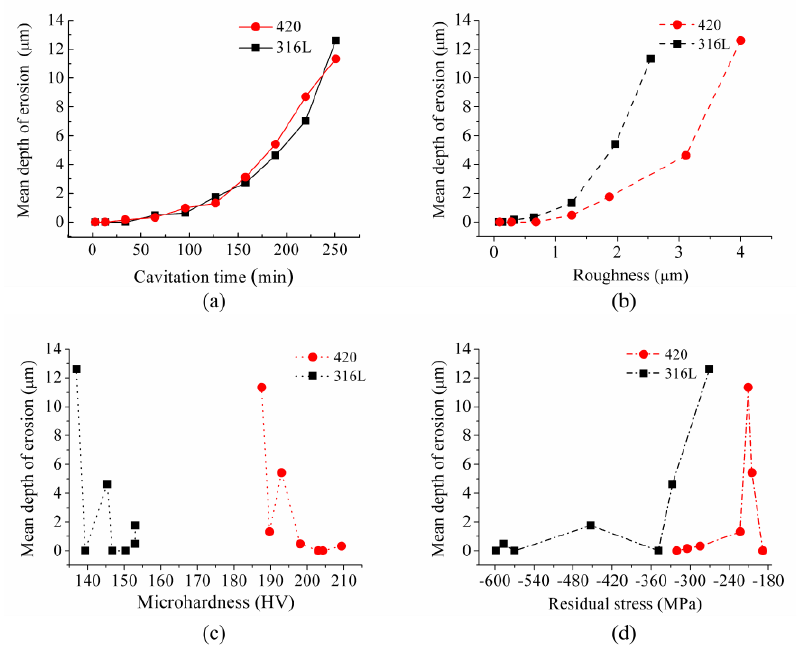
Figure 3. ( a ) Cavitation time, ( b ) roughness, ( c ) microhardness, and ( d ) residual stress as a function of the mean depth of erosion of 420 and 316L.